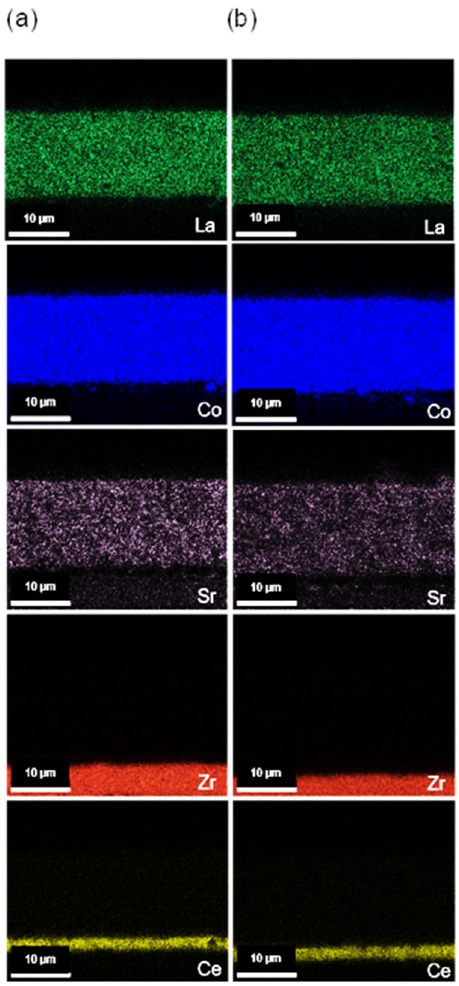
Figure 9. SEM-EDX mapping of single cells towards oxygen electrode side for La (L α , 4.65 keV), Co (K α , 6.92 keV), Sr (L α , 1.81 keV), Ce (L α , 4.84 keV), and Zr (L α , 2.04 keV) ( a ) before, and ( b ) after 1000 h durability test at 800 °C with 50% H 2 + 50% H 2 O.